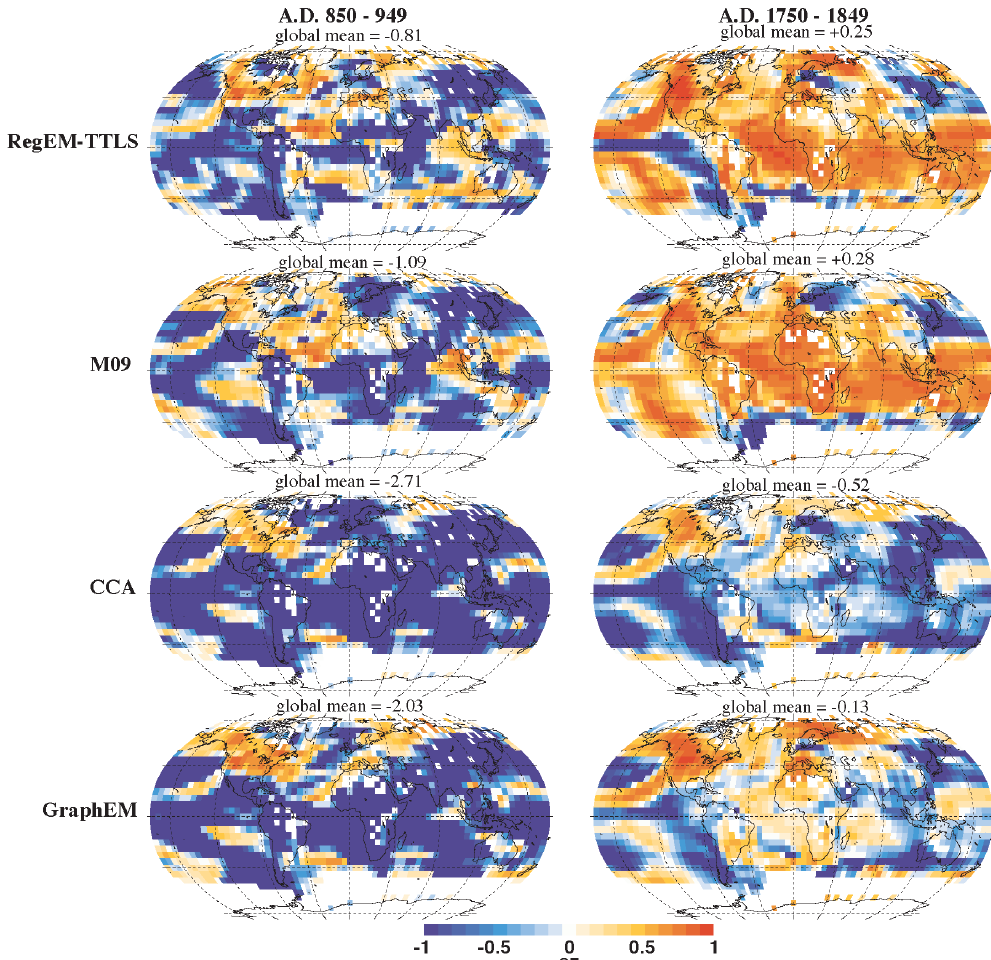
Fig. 9. Spatial pattern of CE, based on ensemble median using the local SNR flat network. 850–949 and 1750–1849AD represent periods with the minimum and maximum global mean CE over the entire reconstruction interval,